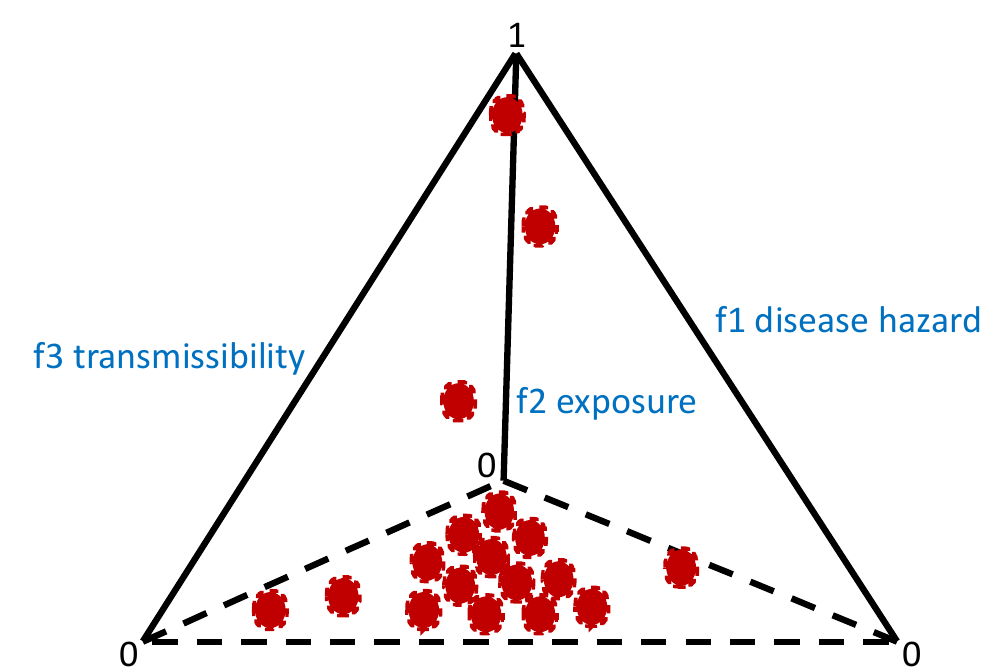
Figure 7. Simplex of risk points that could characterize host population with parasite aggregation. High-risk individual hosts could have high parasite burden. Each red dot could represent an individual host.